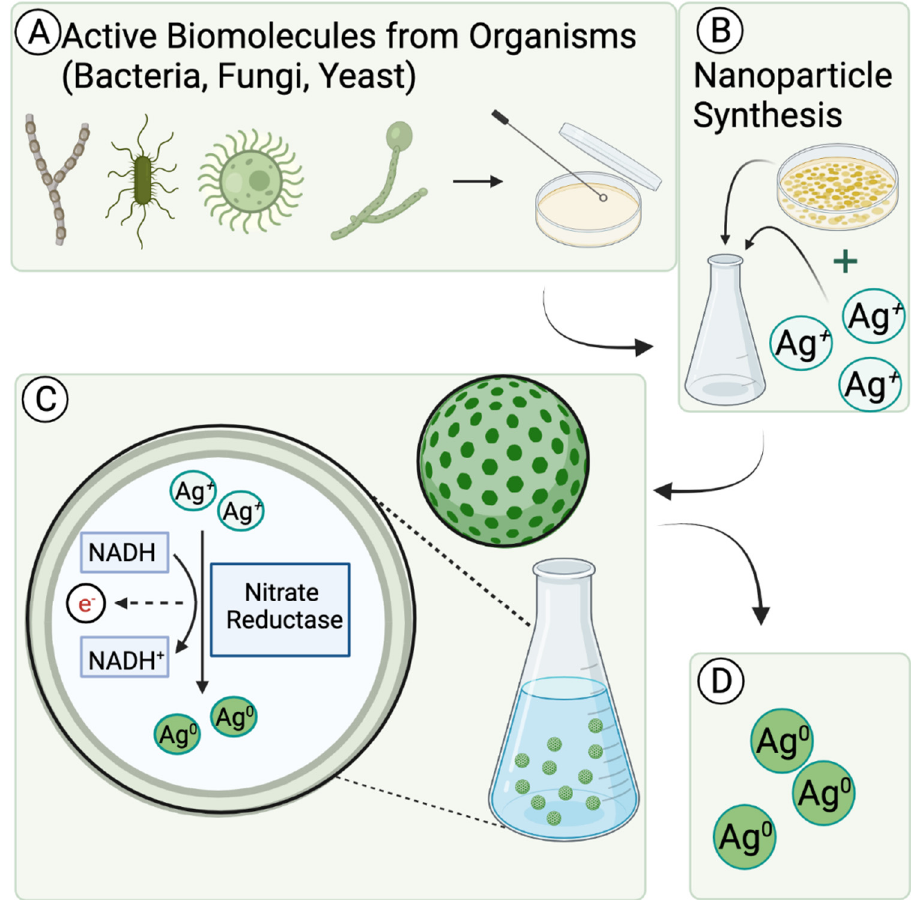
Figure 3. Representation of the role of active molecules in green metallic nanoparticle synthesis. ( A ) Microorganism obtained from raw sample is cultured on a plate. ( B ) Culture is harvested and purified before it is inoculated in sterile nutrient broth with metal ion solution. Methods are taken to promote homeostasis for subsequent nanoparticle synthesis. ( C ) Metal ions are reduced to metal nanoparticles, facilitated by microorganism’s active molecules. The proposed active molecule mechanism reflected in this figure is the intracellular conversion of metal ion to metal nanoparticle through an enzymatic reduction oxidation process. ( D ) Nanoparticles are collected and analyzed for purity and formation. Stability and reducing properties from microorganism can be observed in final product.